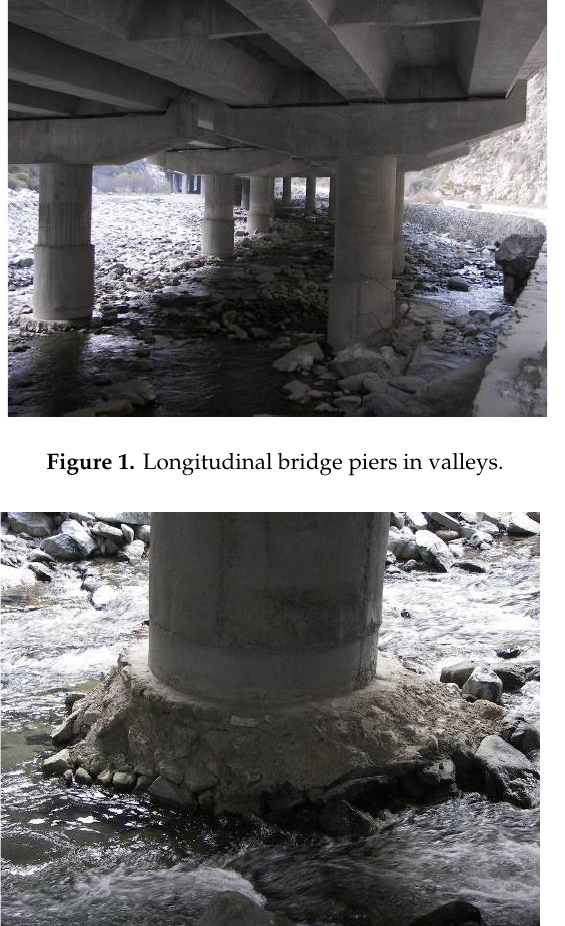
Figure 1. Longitudinal bridge piers in valleys.